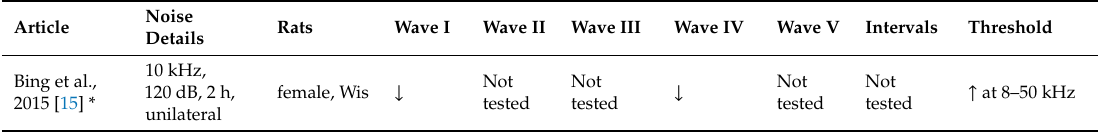
Table 5. Changes in amplitude in rats after noise